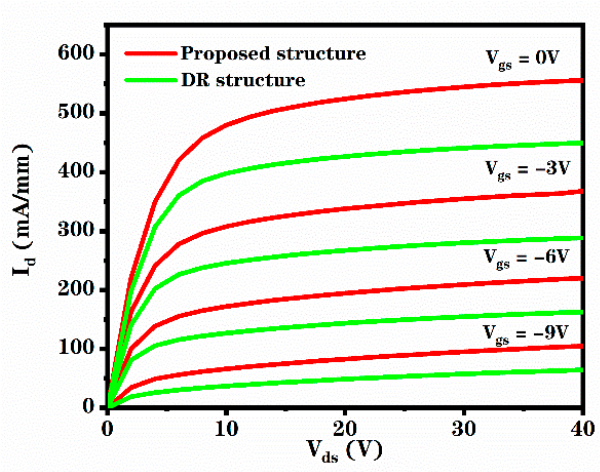
Figure 3. Evolution of drain current (I d )as a function of drain ‐ source voltage (V ds ) for the proposed structure and DR structure.